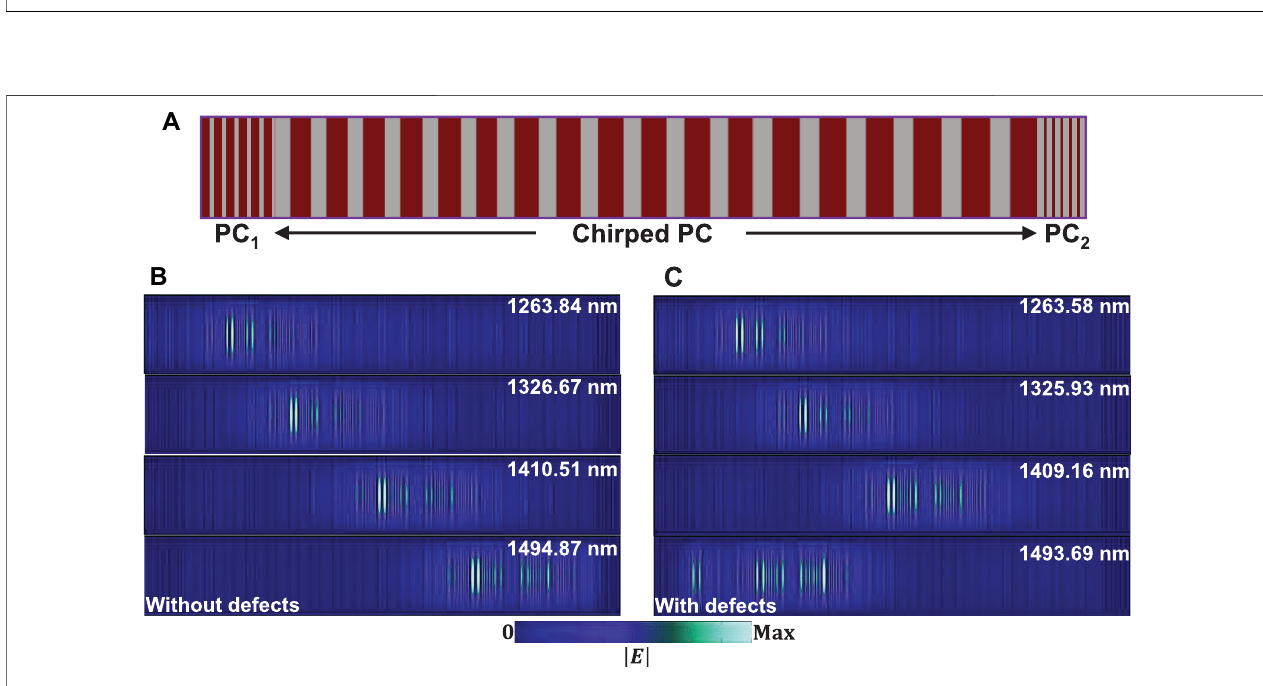
FIGURE5| Bidirectionalrainbowtrappingrealizationwithdisorderingofsomeparameters,theinsetshowsthedeformationinlastand fi rstlayersofPC 2 fromTPC L and TPC R respectively.